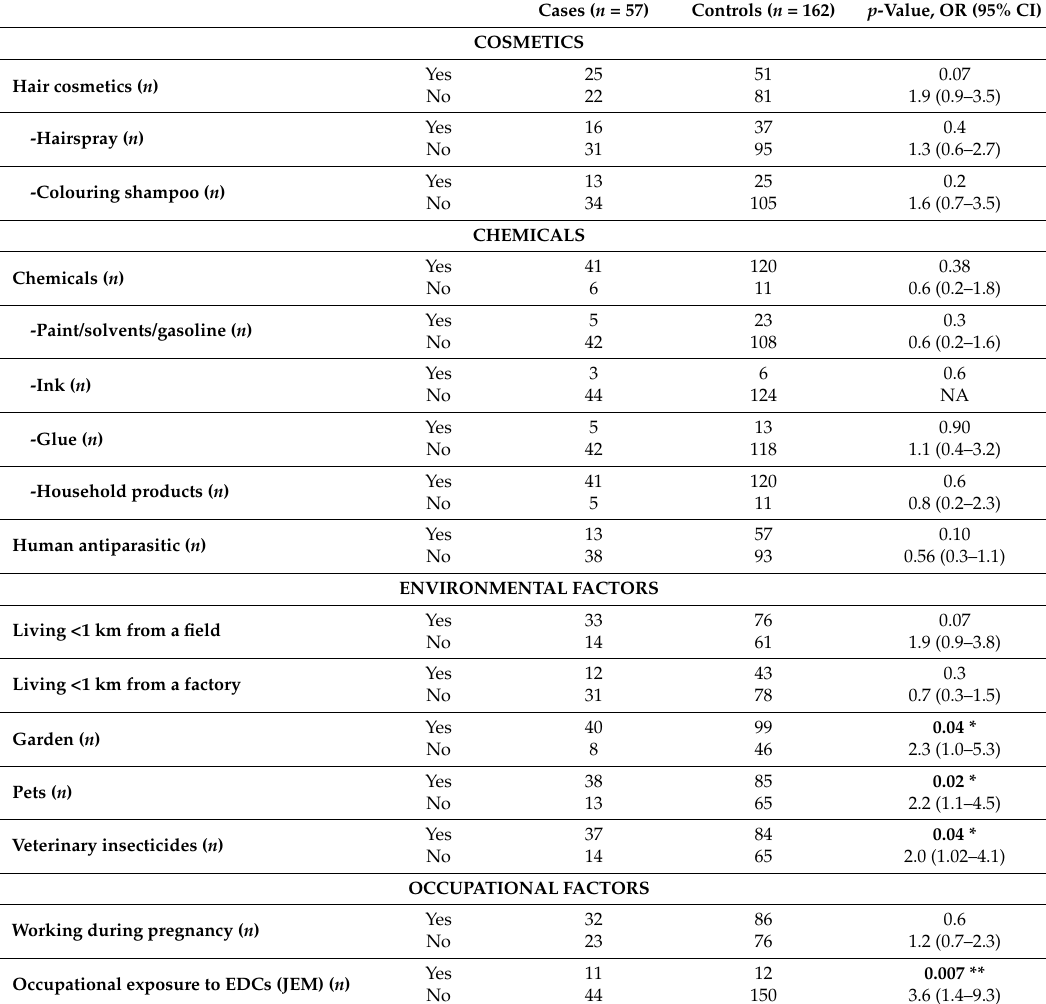
Table 4. Univariate analysis of the association between pollutant exposures during the first trimester of pregnancy and the incidence of